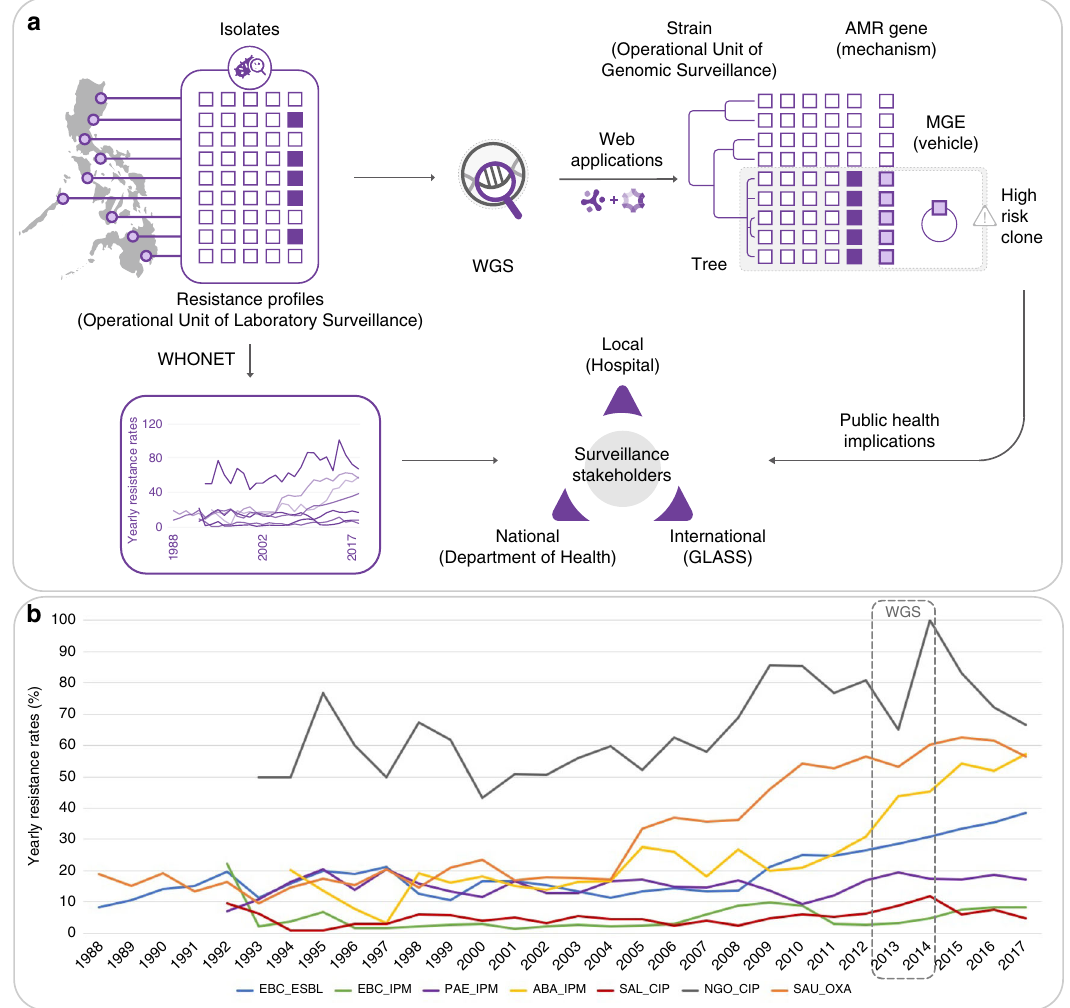
Fig. 1 Implementing whole-genome sequencing (WGS) for AMR surveillance in the Philippines. a ARSP work fl ow and enhanced detection of high-risk clones by WGS. Isolates collected by sentinel sites are tested for susceptibility to antibiotics (open squares: susceptible, solid squares: resistant). The data are stored as resistance pro fi les in WHONET and summaries of resistance trends are shared yearly with surveillance stakeholders. WGS of bacterial isolates and interpretation with web applications like Microreact and Pathogenwatch provide information on genetic relatedness (strains), known AMR determinants (mechanisms), and the mobile genetic elements (MGE, vehicles) for their dissemination, thus allowing us to detect high-risk clones. b Detail of trends in antimicrobial resistance in the Philippines. Yearly resistance rates for key bug – drug combinations based on phenotypic data collected by sentinel sites. EBC Enterobacteriaceae ( K. pneumoniae , E. coli , Salmonella enterica ), PAE P. aeruginosa , ABA A. baumannii ( Acinetobacter spp. before the